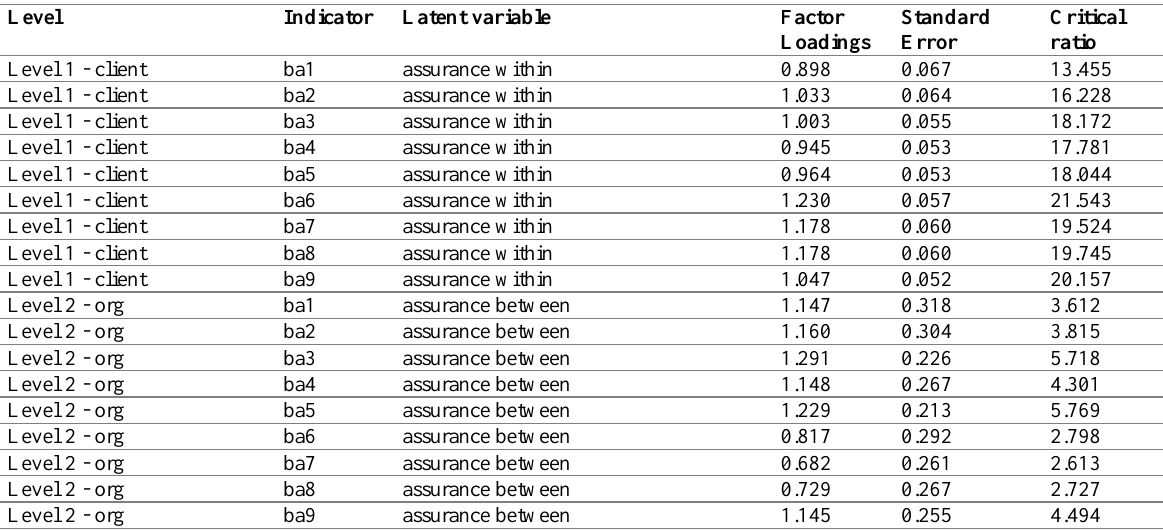
Table 1: Summary of Assurance Measurement Loadings